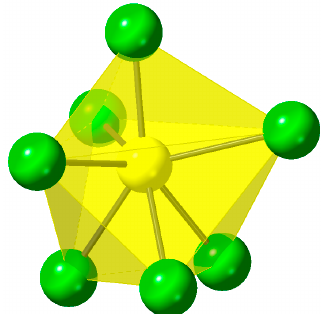
Figure 3. Na coordination in verneite. The three-fold axis is vertical. Projection based on crystal structure data from Reference [13].